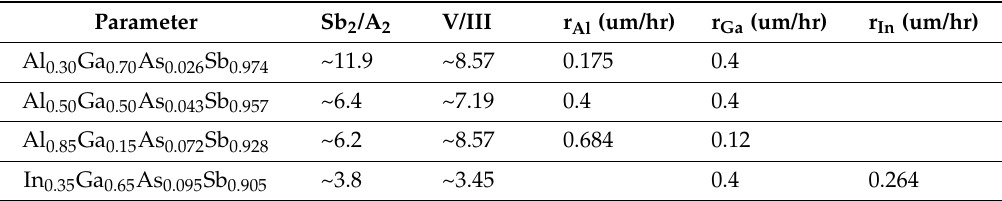
Table 1. Optimized growth parameters of target bulk AlGaAsSb alloys at ~480 ◦ C and